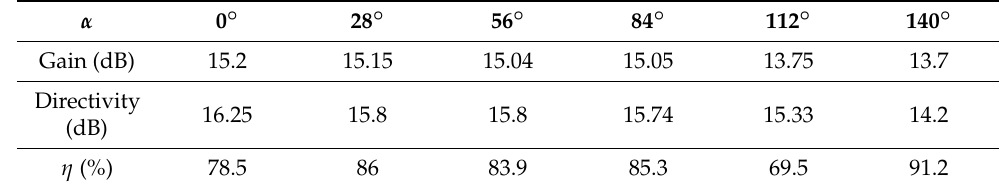
Table 2. Measured realized gain, simulated directivity in dB and efficiency η in % for the six different progressive phases α ranging from 0 ◦ to 140 ◦